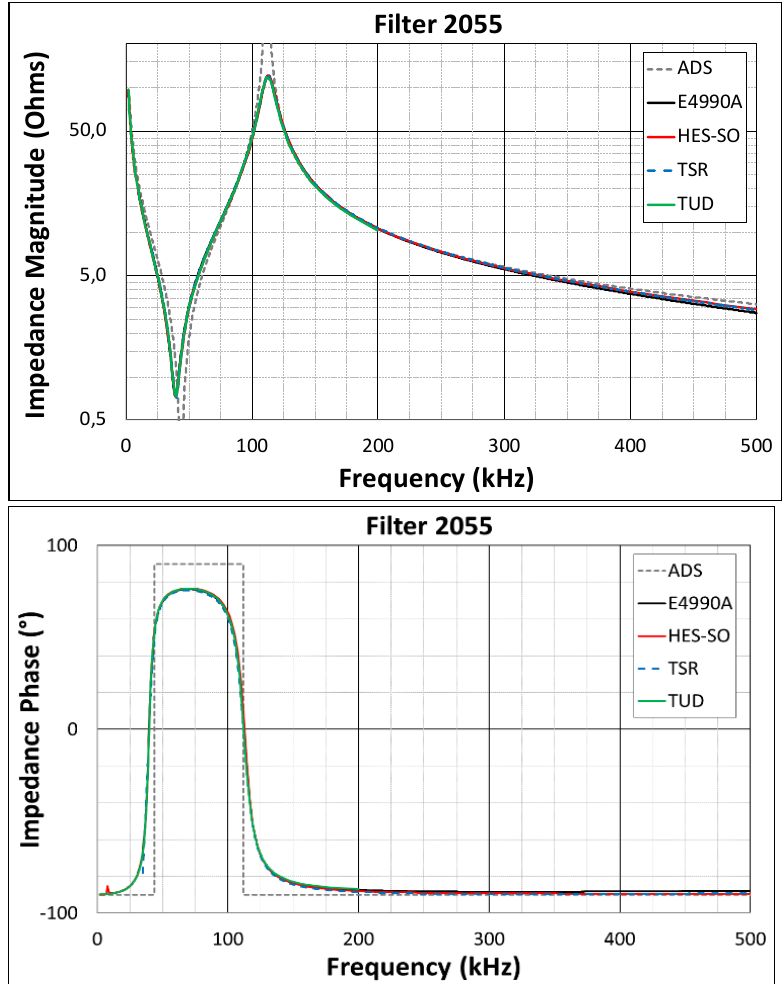
Figure 6. Schematics of the Electromagnetic Compatibility (EMC) filter 2055.